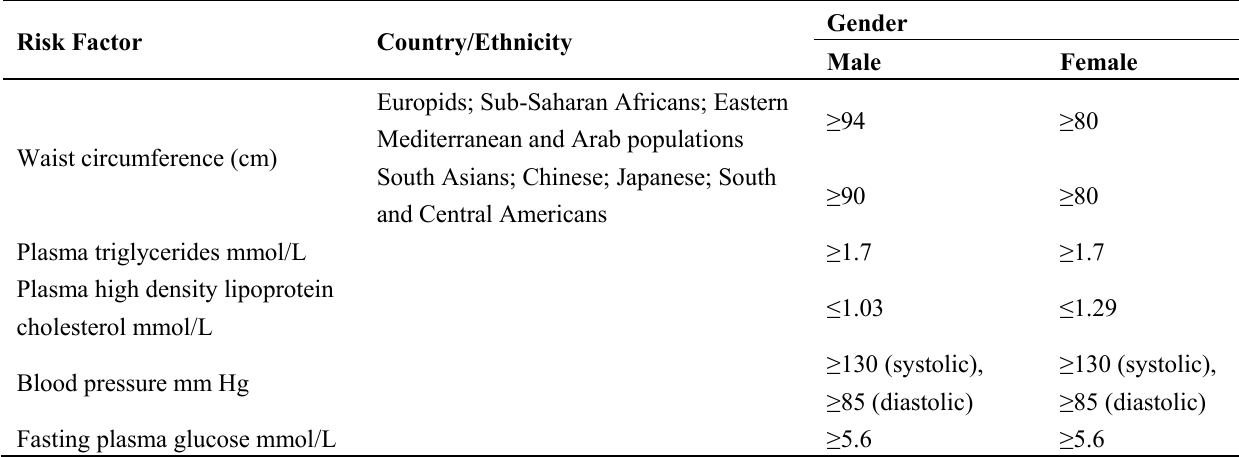
Table 1. Definition of metabolic syndrome 1